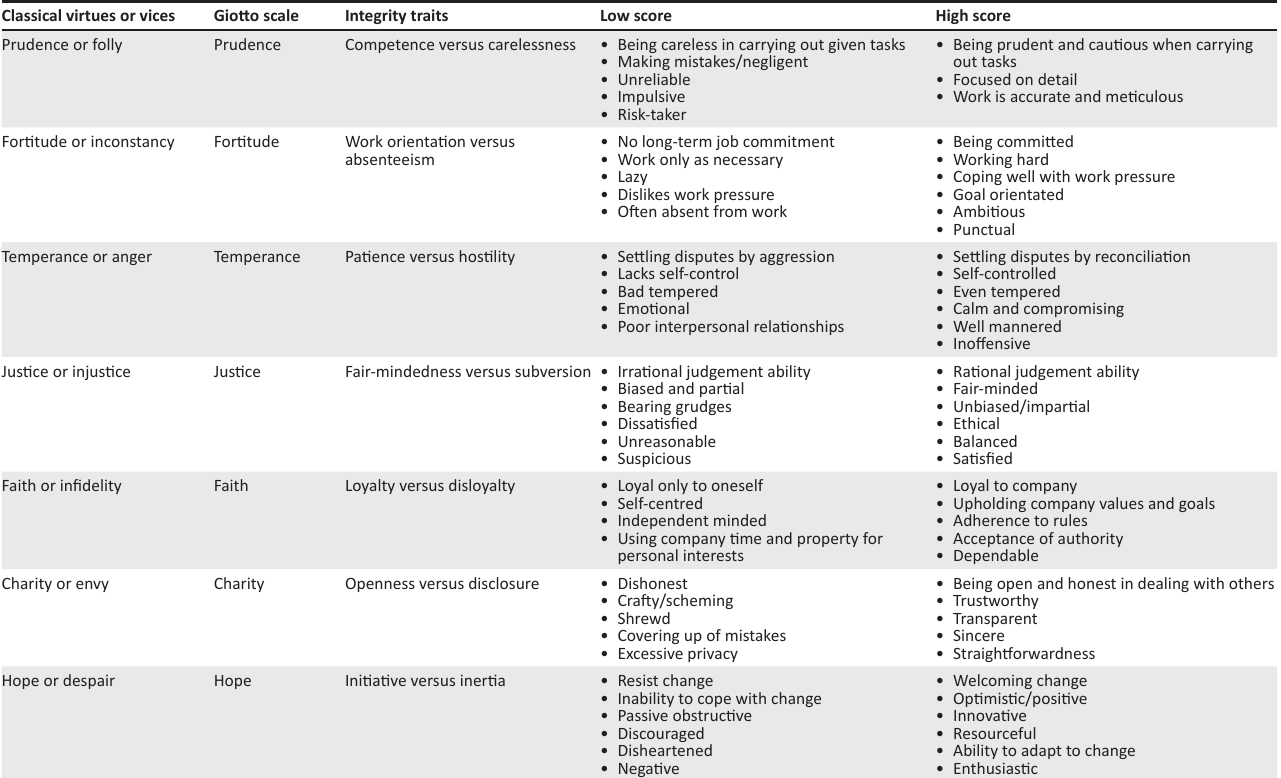
TABLE 1: Classical virtues or vices and integrity traits measured by the Giotto Integrity Test. Classical virtues or vices